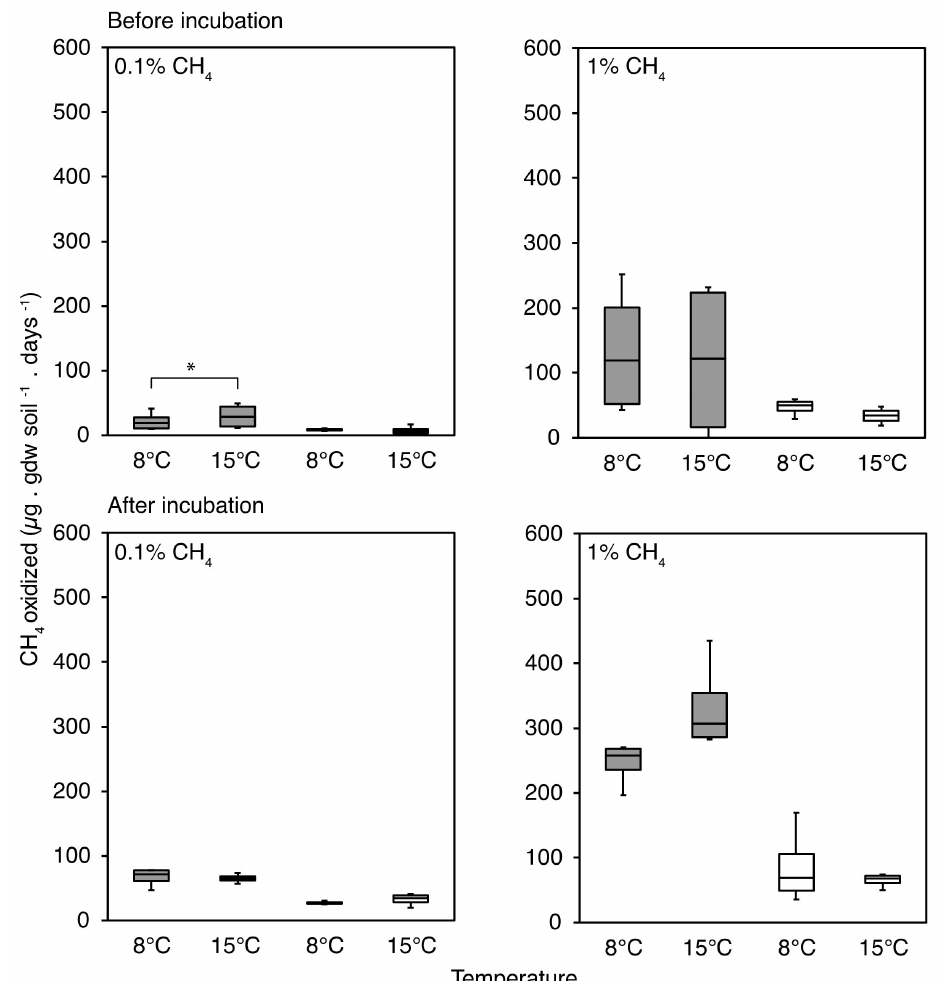
Figure 2. CH 4 oxidation rates from Exp I, emphasizing the comparison between 8 ◦ C and 15 ◦ C. Results are shown for measurements collected before (top) and after (bottom) the three-week incuba- tion period, and at 0.1% (left) and 1% CH 4 (right). Grazed microcosms are shown in gray; exclosed microcosms in white. Comparison using linear mixed models with peat blocks as random variables shows significant differences in the CH 4 oxidation rates between temperatures (* p = 0.05–0.01). 3.3. CH 4 Oxidation in a Pure Culture of M. Tundripaludum SV96 in Response to